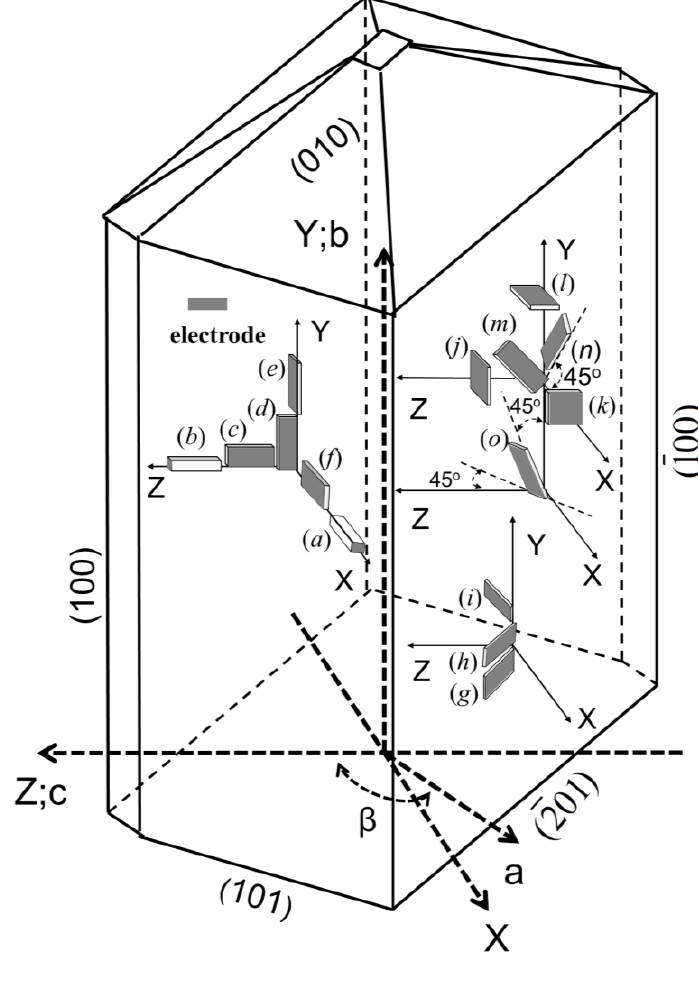
Figure 5. Crystal cuts for electro-elastic parameter determination (( a ) X rod; ( b ) Z rod; ( c ) XZ plate; ( d ) XY plate; ( e ) ZY plate; ( f ) ZX plate; ( g ) ( XZw )45°; ( h ) ( XZw )30°; ( i ) ( XZw )−45°; ( j ) Z- square plate; ( k ) X- square plate; ( l ) Y- square plate; ( m ) ( XYt )45°; ( n ) ( ZXt )45°; ( o ) ( YZtw )